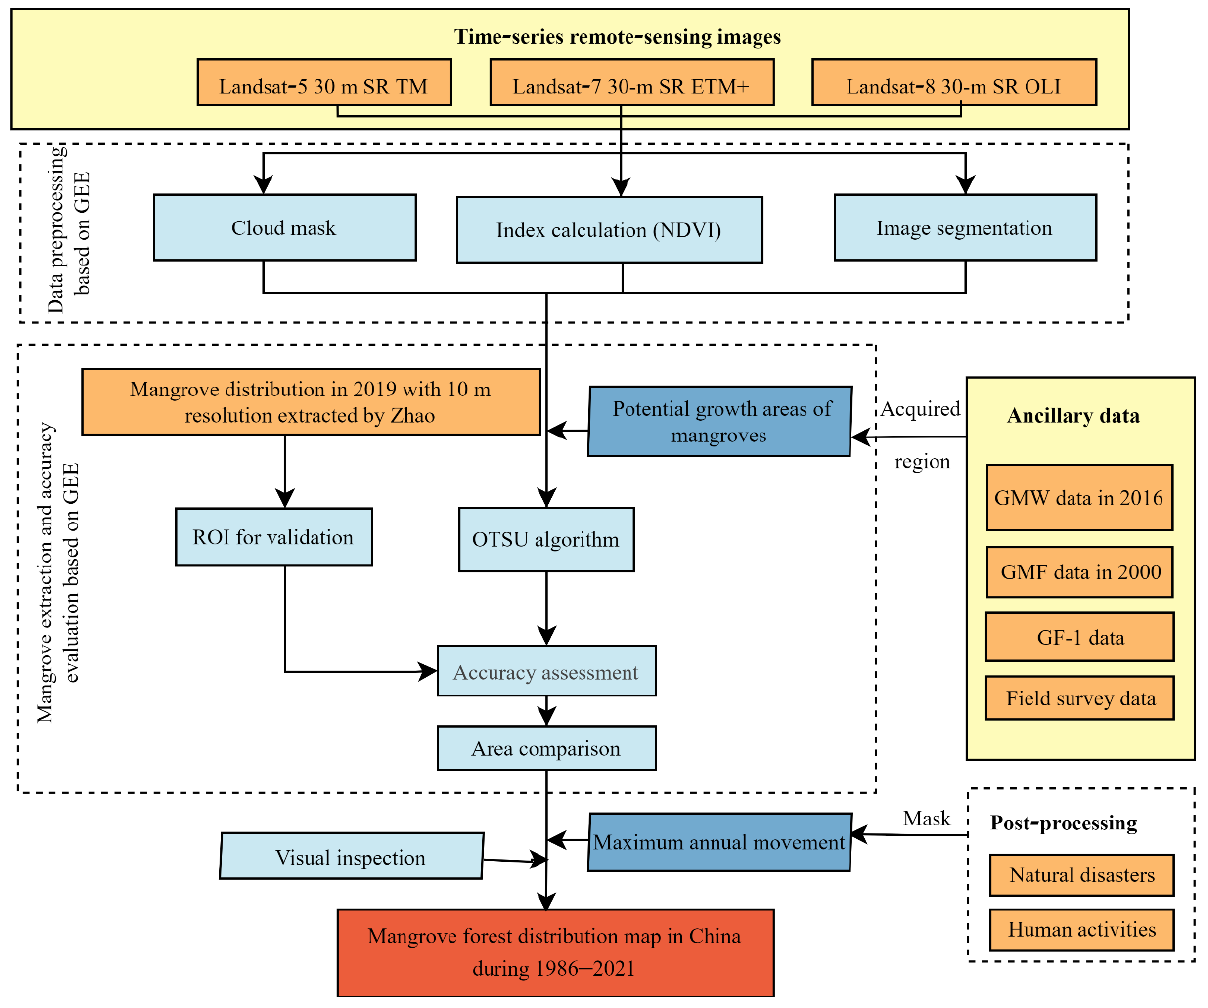
Figure 3. Flowchart. Figure 3.